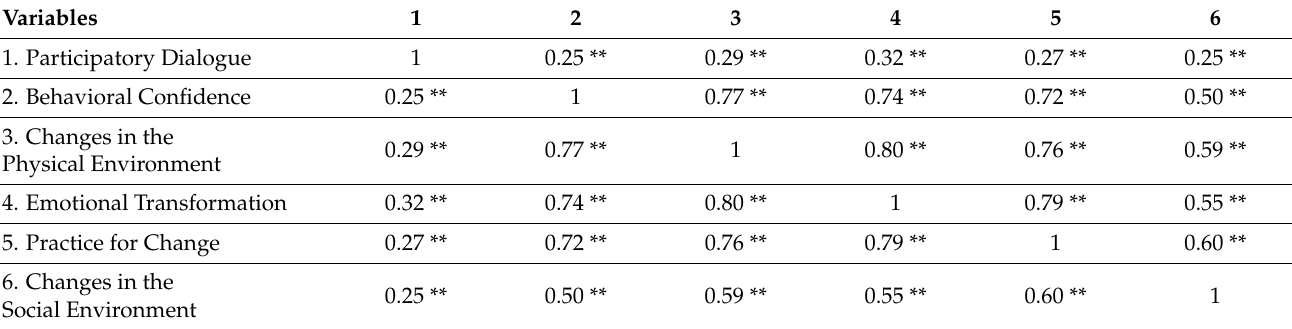
Table 5. Pearson correlations between MTM constructs used in this